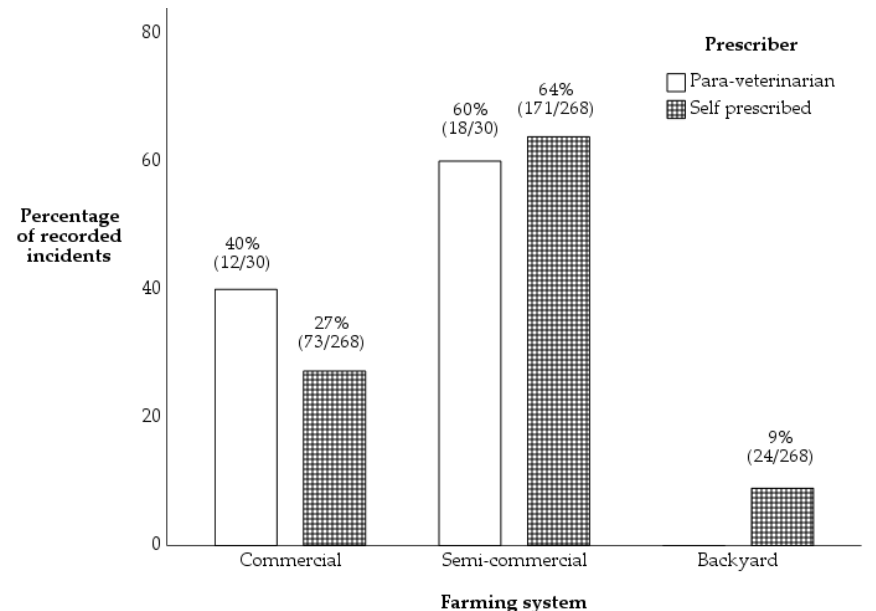
Figure 3. Association between 298 of 309 incidents where antimicrobials were prescribed (para-veterinarians n = 30, self-prescribed n = 268) and ( A ). different enterprises (Fisherman’s exact test, p = 0.017) and ( B ). different farming systems (Fisherman’s exact test, p = 0.111) located in the Central and Western divisions of Viti Levu, Fiji. Veterinarians only prescribed in commercial broiler enterprises ( n = 11 incidents) and were excluded from the analysis.